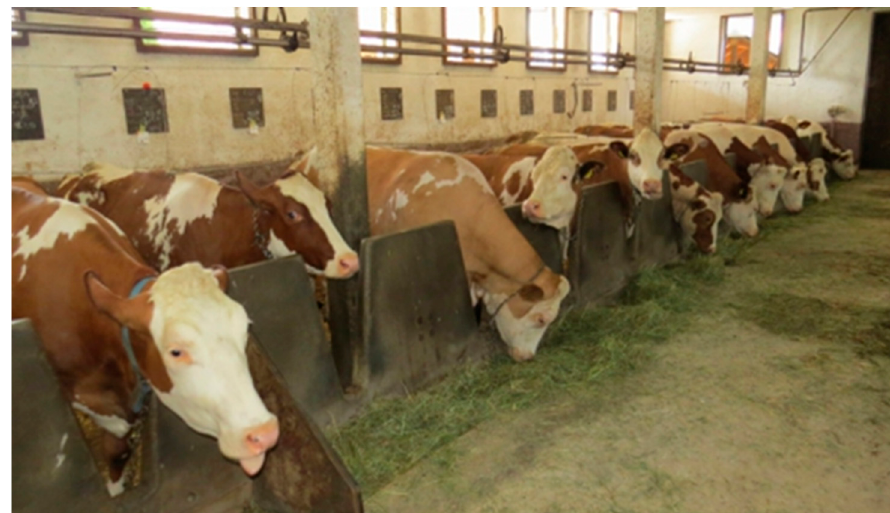
Figure 1. Tie-stall barn.